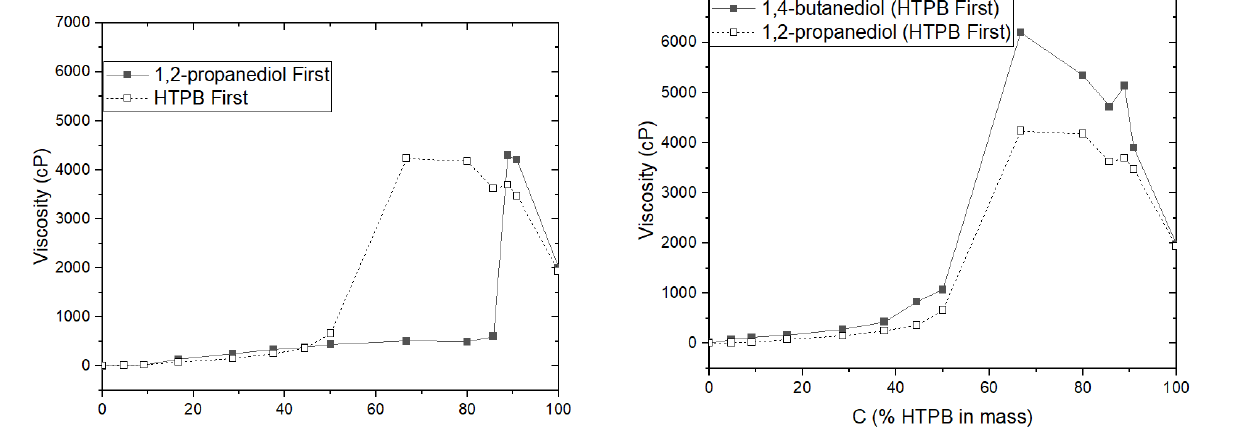
Figure 3. Comparison of the viscosity profile of solutions with 1,4-butanediol and 1,2-propanediol, depending on the resin concentration, adding HTPB resin first.